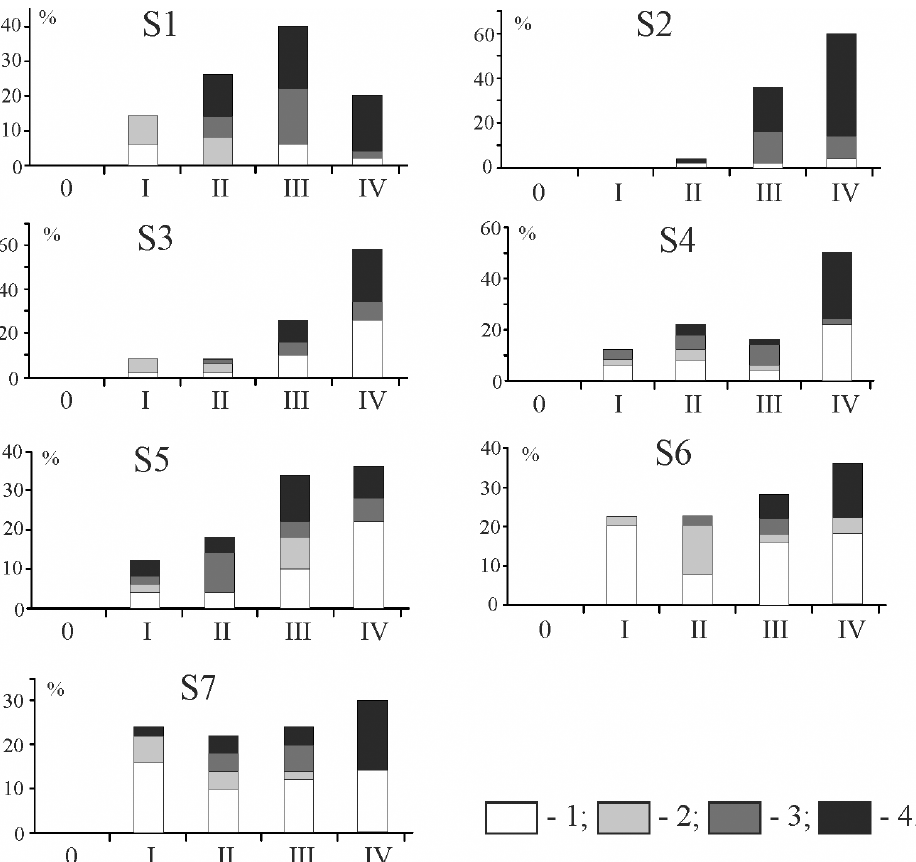
Figure A2. Distribution of quartz sand grains from section NS-6 by roundness and dullness. (1) Glossy; (2) quarter-matte; (3) half-matte; (4) matte; 0, I, II, III and IV are grades of roundness according to Khabakov